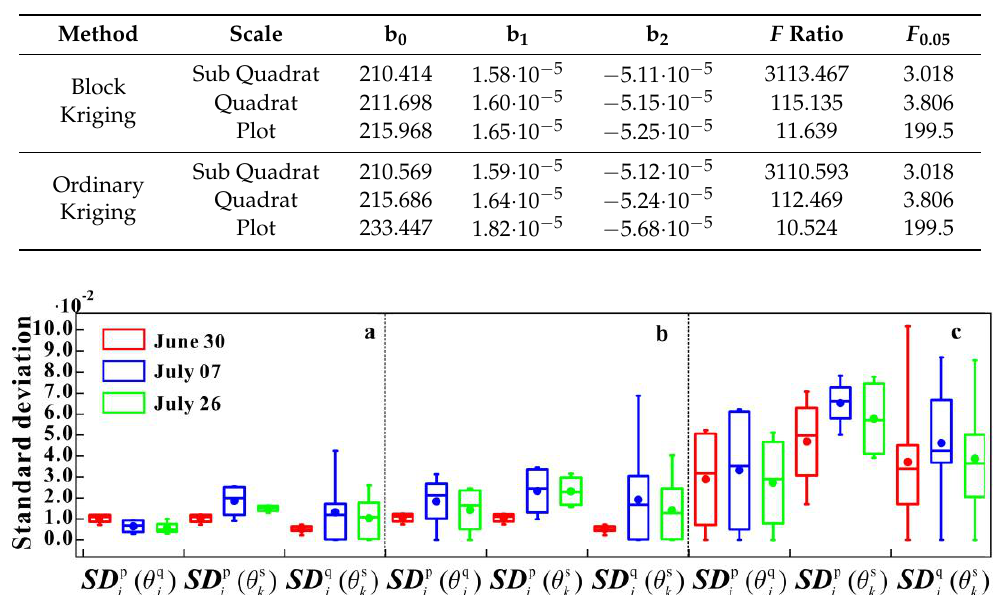
Table 9. The linear trend surface analysis for SoilNET and WaterNET merged data on 30 June. ( F 0.05 : F value with a significance level of 0.05).